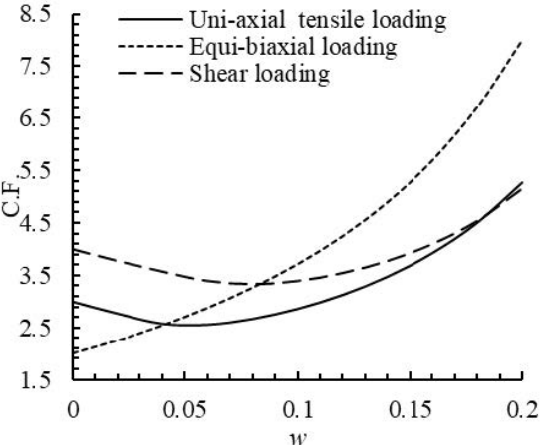
Figure 12. Variations of the C.F. in terms of w in different loading ( c = 1).